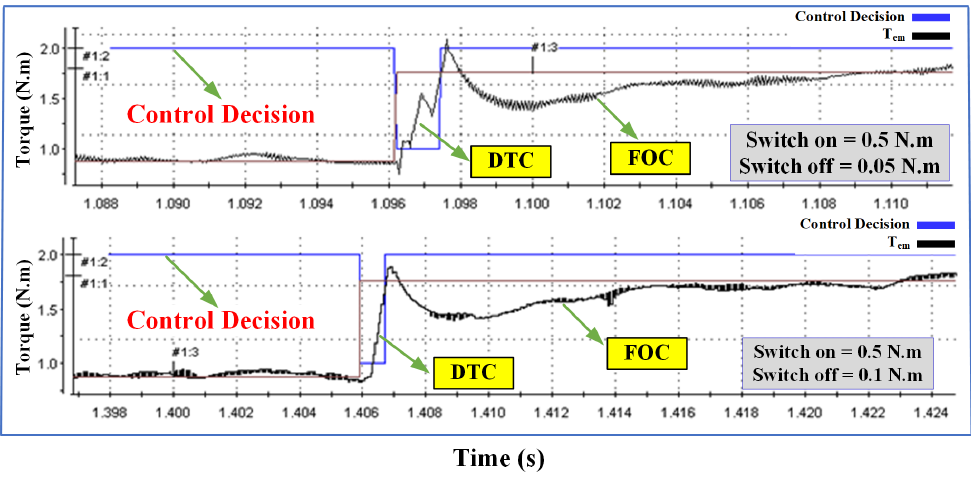
Figure 36. The torque response in the combined FOC-DTC algorithm with different values of switch-